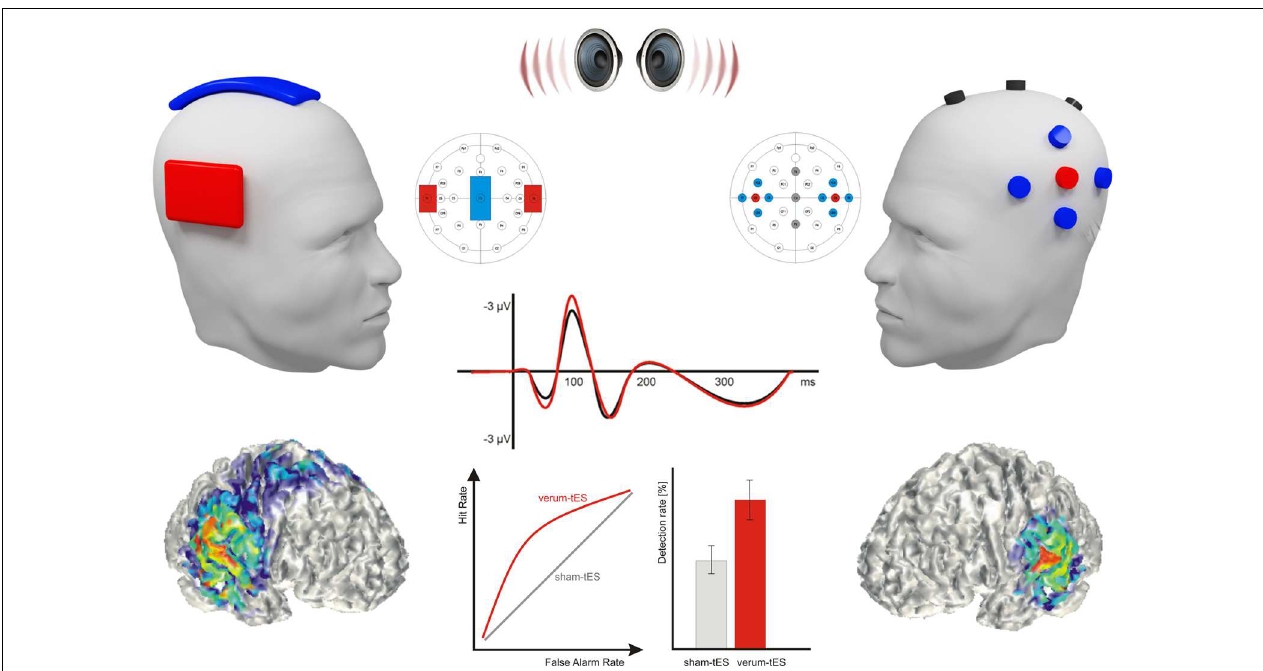
FIGURE 2 | Illustration of the auditory tES effects. Figure exemplifies two different electrode montage schemas: conventional tES (left) with active sponge-pad electrodes over the target areas and a larger reference electrode over the vertex and 4 × 1 High-Definition (HD)-tES (right) with central active ring electrodes surrounded by four reference electrodes. While the conventional tES schema enables the online assessment of behavioral effects only, HD-tES additionally allows for the online assessment of EEG from midline electrodes (e.g., Fz, Cz, Pz). Both tES schemas induce current density maxima at the auditory cortices (AC) leading to alterations of the neuronal reactivity within the stimulated area. As illustrated below, whereas conventional tES innervates rather broad cortical areas, HD-tES is supposed to allow for a more focal stimulation. In consequence auditory tES results in changes in the electrophysiological reactivity to auditory stimulation [such as altered P50-N1 amplitudes of the auditory evoked potential (AEPs)] and in corresponding alterations in auditory task performance (e.g., enhanced perceptual sensitivity or detection